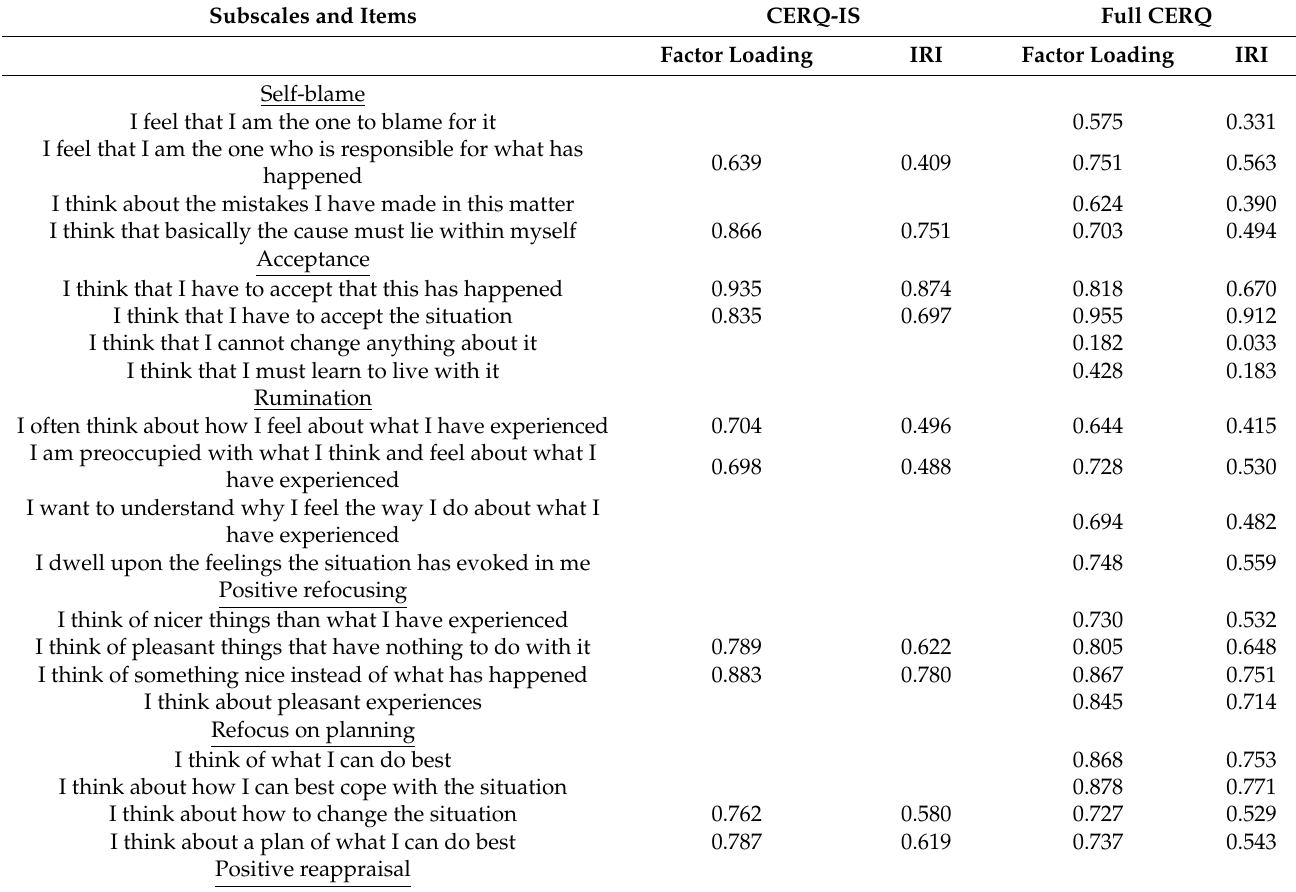
Table 1. Factor structure of the 18-item short (CERQ-IS) and 36-item full (Full CERQ) versions of the CERQ. All the factor loadings obtained from the CFA solutions are reported in completely standardized metric and are statistically significant ( p < 0.001). Abbreviations: CERQ, cognitive emotion regulation questionnaire; CERQ-IS, Italian short version of the cognitive emotion regulation questionnaire; IRI, item reliability